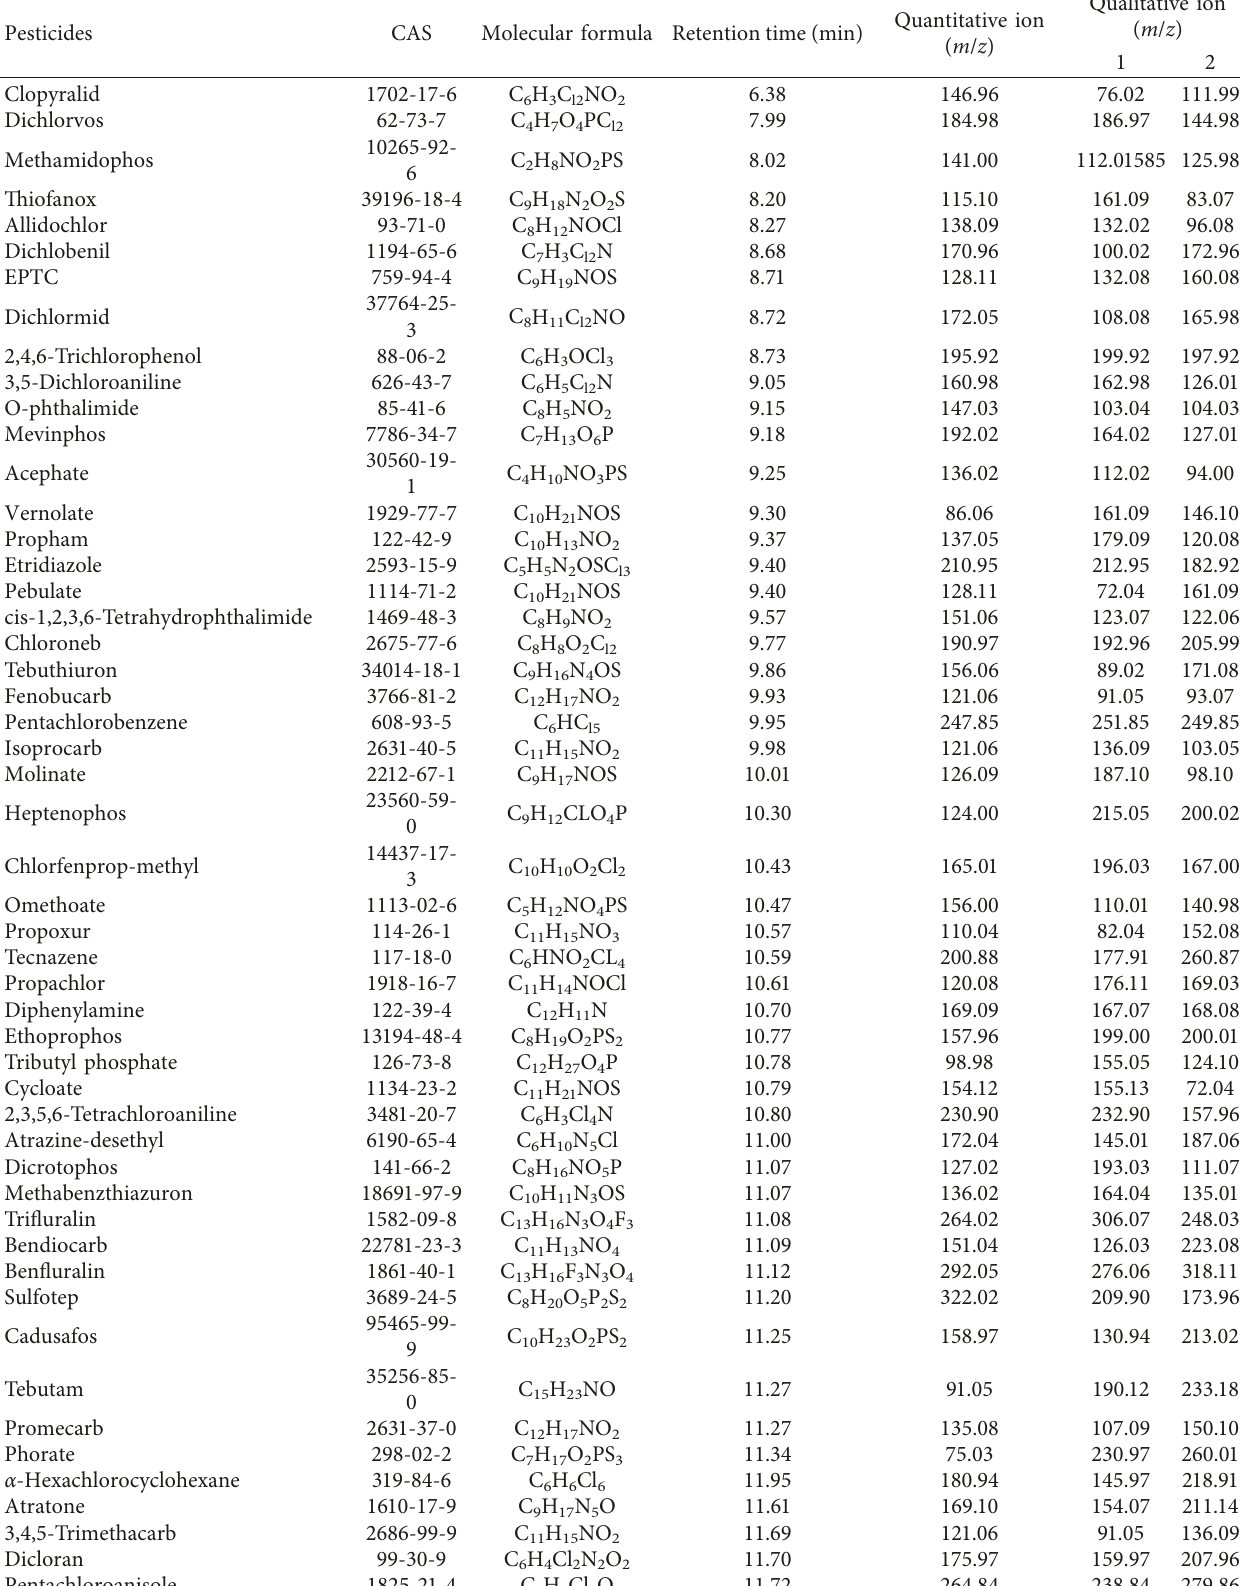
Table 1: Information of the 352 pesticides detected in chrysanthemum flower samples by GC-Orbitrap-MS screening.